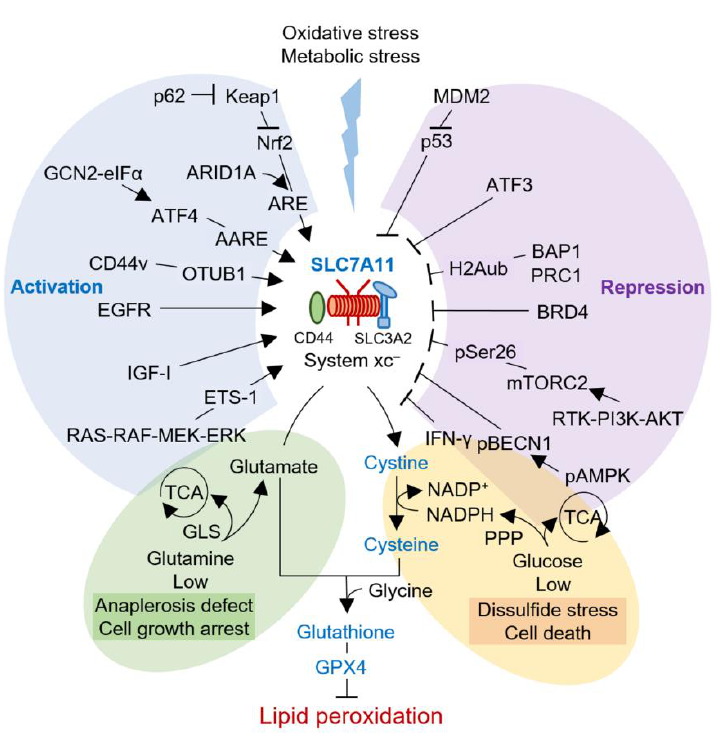
Figure 2. Regulators of the SLC7A11–cysteine–GSH axis in cancer cells. Cellular cysteine is mainly acquired by cystine uptake from extracellular sources via SLC7A11. SLC7A11 expression can be activated or repressed via various regulatory mechanisms at the transcription, translation, and posttranslational levels. Cancer cells require large amounts of cysteine and GSH to neutralize the increased intracellular ROS, and the nutrient dependency generally needs the increased function of SLC7A11. These cancer cells may be rendered more susceptible to limiting glucose or glutamine supply. SLC7A11 overexpression is found in many human cancers and is highly sensitive to selec- tive inhibition of SLC7A11 or cyst(e)inase. AARE, amino acid response elements; AMPK, AMP- activated protein kinase; ARE, antioxidant response element; ATF4, activating transcription factor 4; BAP1, BRCA1-associated protein-1; BRD4, bromodomain-containing protein 4; CD44v, CD44 variant; EAAT3, excitatory amino acid transporter 3; EGFR, epidermal growth factor receptor; GCN2-eIF2 α , general control non-derepressible-2-eukaryotic initiation factor 2 α ; IFN- γ , interferon-gamma; IGF-I, insulin-like growth factor-I; Keap1, Kelch-like ECH-associated protein 1; MDM2, murine double minute 2; mTORC2, mammalian target of rapamycin complex 2; Nrf2, nuclear erythroid 2-related factor; OTUB1, ubiquitin hydrolase otubain-1; pBECN1, phospho-beclin-1. ATF4 is involved in redox homeostasis, amino acid metabolism, and endoplasmic reticulum stress to promote the transcription of SLC7A11. Amino acid starvation, endo- plasmic reticulum stress, and hypoxia may increase ATF4 mRNA translation through the general control non-derepressible-2 (GCN2)- eukaryotic initiation factor 2α (eIF2α) signal- ing axis [30]. Consequently, ATF4 binds to the amino acid response elements (AARE) and promotes the transcription of genes involved in stress response, including SLC7A11, thereby enabling cells to cope with amino acid deficiency [30]. ATF4 promotes ferroptosis resistance in cancer cells by upregulating SLC7A11 as an adaptive response to cystine deficiency [31]. The Kelch-like ECH-associated protein 1 (Keap1)-Nrf2-activator protein-1 (AP-1)/antioxidant response element (ARE) signaling pathway increases the transcription of genes responsible for resistance to oxidative stress, including SLC7A11 [32]. Nrf2 is unstable under basal conditions and is ubiquitinated by an E3 ubiquitin ligase Keap1. Oxidative stress impairs Nrf2 degradation by Keap1 and allows Nrf2 to bind to ARE, which is involved in antioxidant defense and redox maintenance. In cancer cells, Keap1 inacti- vation promotes ferroptosis resistance following SLC7A11/cysteine/GSH axis activation